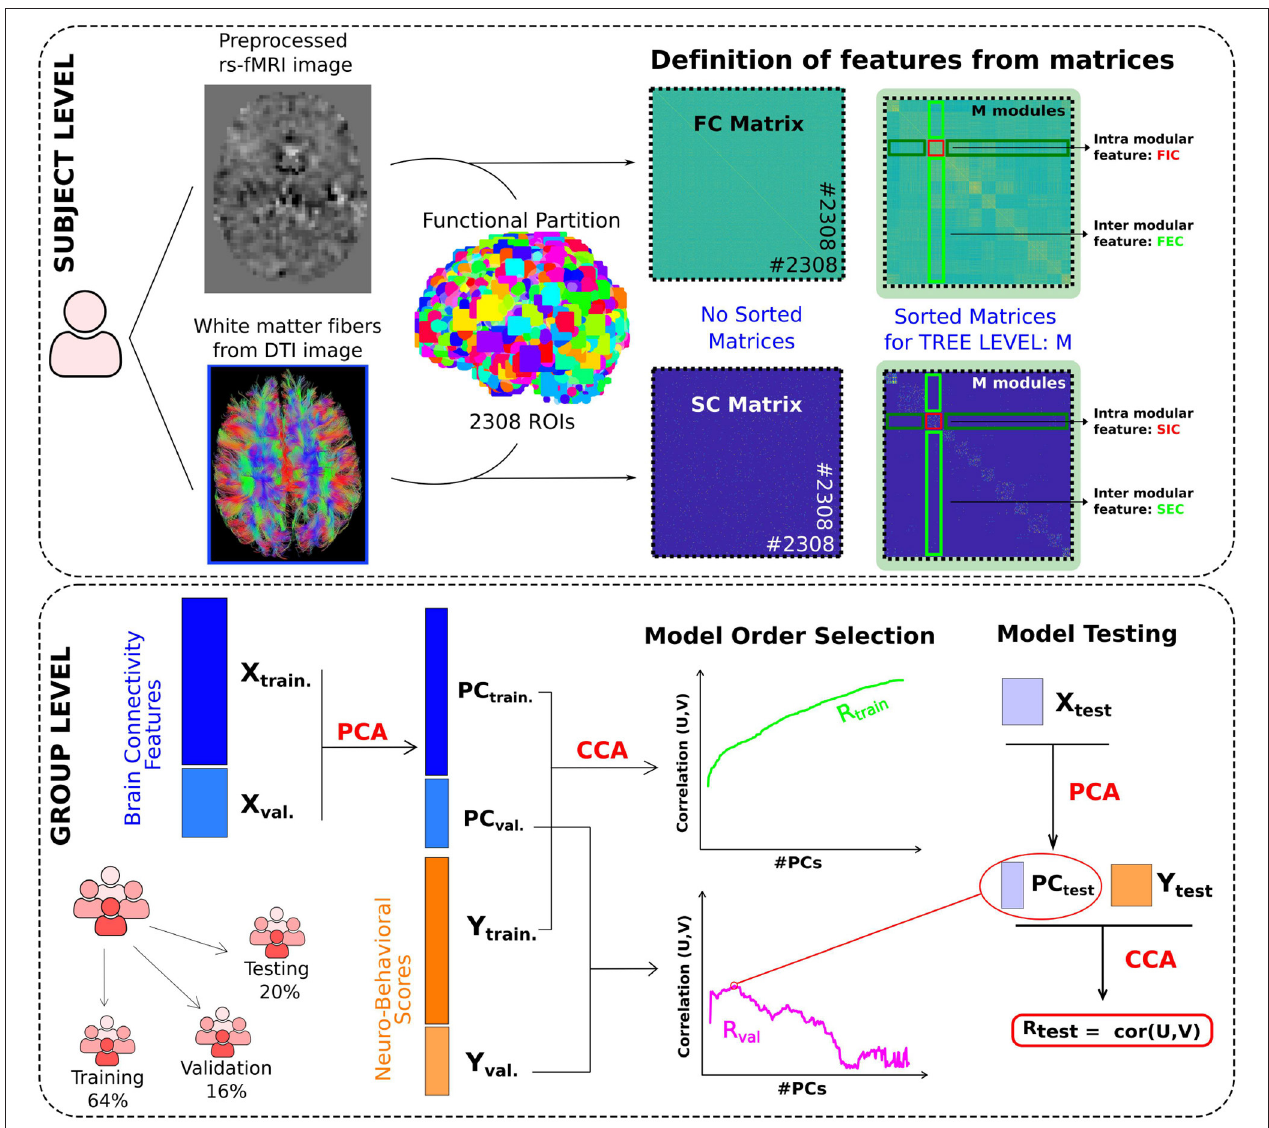
FIGURE 1 | Brain mapping of neuro-behavioral scores using multimodal and multiscale networks through canonical correlation analysis. Subject level: FC and SC brain networks were built respectively from two data modalities: resting functional imaging (rs-fMRI) and diffusion tensor imaging (DTI). An initial functional brain partition of 2,308 microregions (ROIs) was built, which represents the lowest level (with highest spatial resolution) of our hierarchical partitioning. For the different M levels in the hierarchical tree (here, we varied M from 20 to 1,000), we built for each module in the M level four classes of connectivity features: FIC, FEC, SIC and SEC. This procedure provided a total number of 5,208 multi-scale connectivity features for each subject, 2,587 structural and 2,621 functional, which were used for the following analyses. Group level: Three different cohorts have been used, Training, Validation and Testing. The training and validation datasets were used for selecting the number of principal components (PCs) to reduce the original X dimensionality, containing all connectivity-features. Such a number, considered here as the model order, will be finally used to predict the neuro-behavioral scores (Y) by means of CCA in the test dataset, which provides the final performance (measured by Rtest) in the association between connectivity and